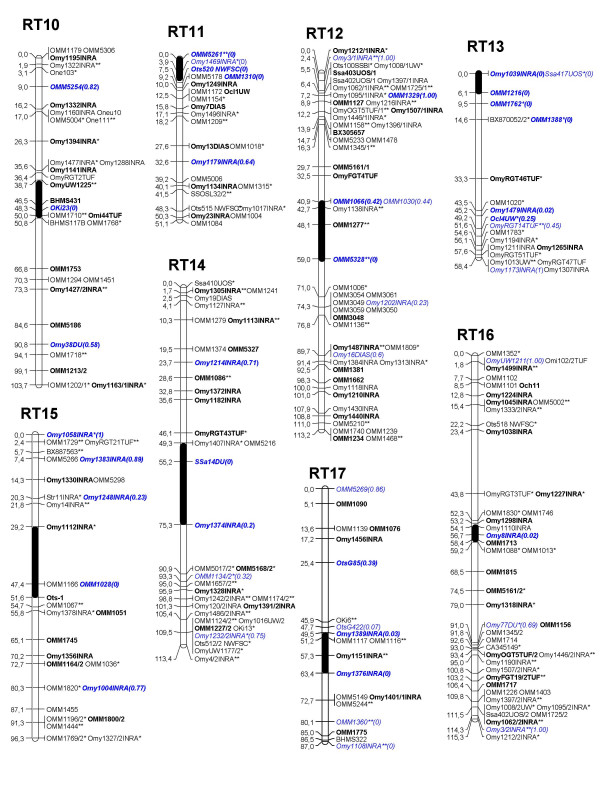
Graphic representation of linkage groups RT10 to RT17. Legends are the same as in Figure 1.